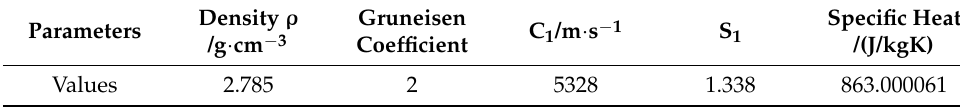
Table 3. Material parameters of AL 2024-T4 [23].